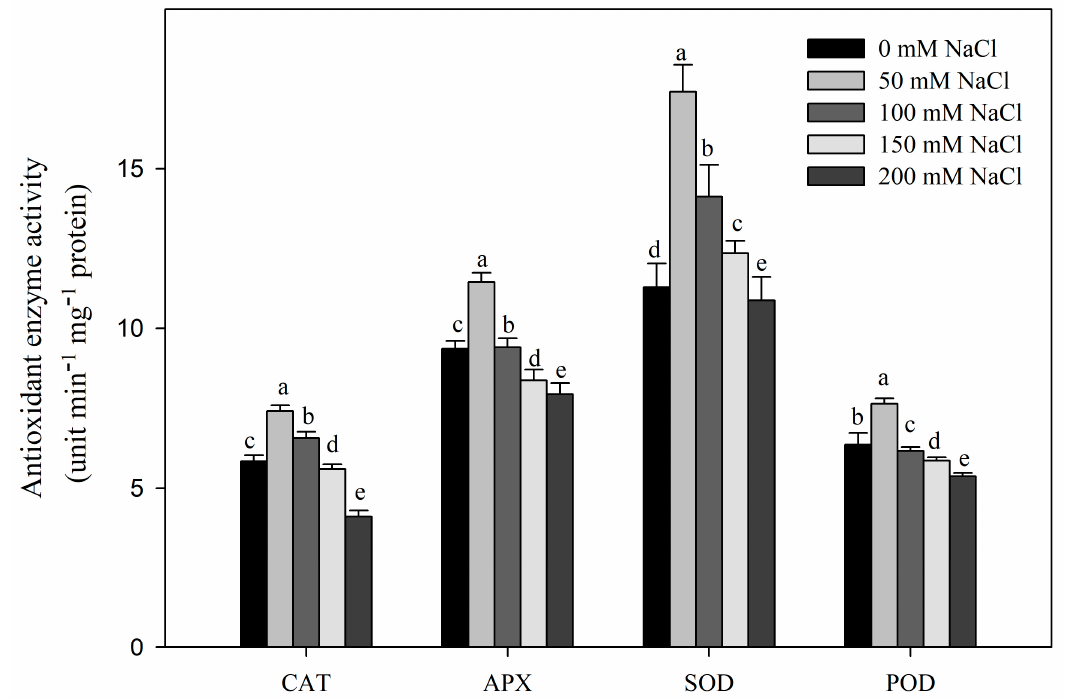
Figure 5. Effect of NaCl stress on activities of CAT, SOD, APX, and POD in R. pseudoacacia seedlings. Values are mean ± SD of five biological replicates. Bars with different letters are significantly different at p < 0.05 according to Duncan’s multiple range tests.